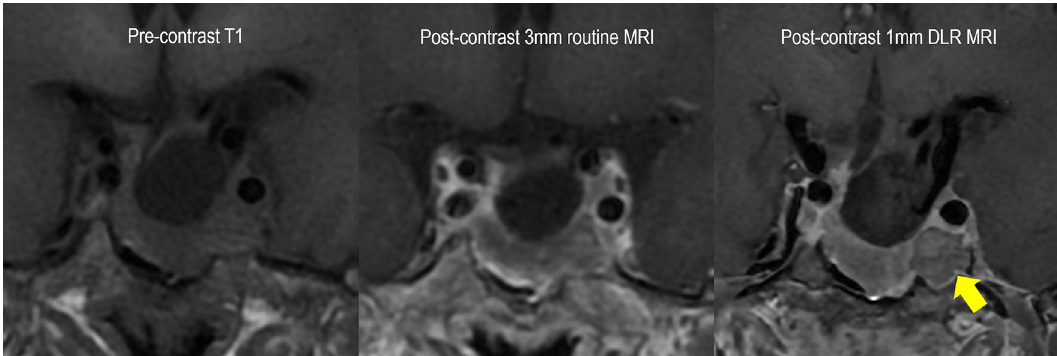
Figure 2. Representative case of postoperative state of pituitary adenoma with a residual lesion. A 52-year-old female patient underwent transsphenoidal resection of a non-functioning pituitary adenoma and underwent follow-up MRI 3 months later. She had residual tumour measuring 14 mm in the left cavernous sinus, which was not delineated on 3 mm MRI. However, 1 mm DLR shows the residual tumour clearly with improved sharpness of the edges. MRI = magnetic resonance imaging, 1 mm DLR = 1 mm slice thickness MRI with deep learning-based reconstruction.